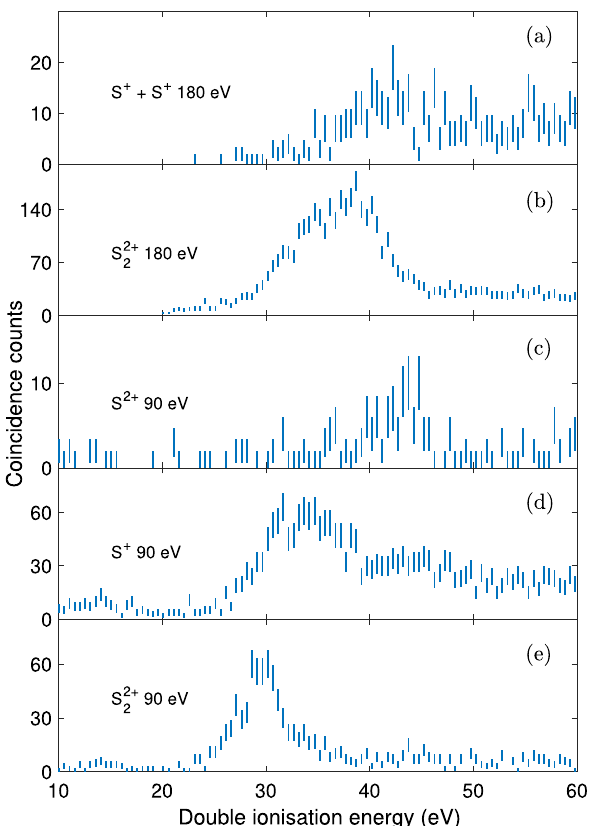
Figure 4. Double ionisation electron spectra obtained at the photon energies of 90 and 180 eV, based on + + , ( a ) and ( d ), or S 2 + signals, ( c ). Error bars show only the electron pairs in coincidence with S 2 2 , ( b ) and ( e ), S statistical uncertainty of the included coincidence